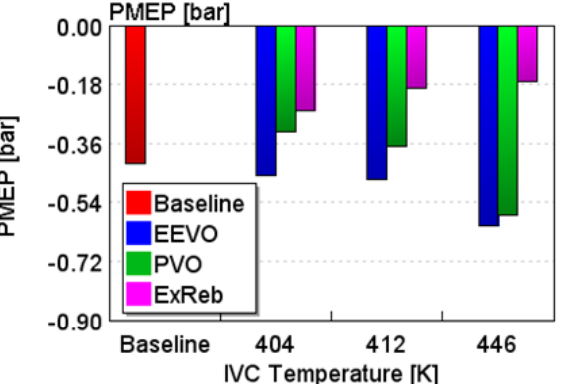
Figure 13. PMEP comparison among the EEVO, PVO, and ExReb strategies at different Tivc levels.